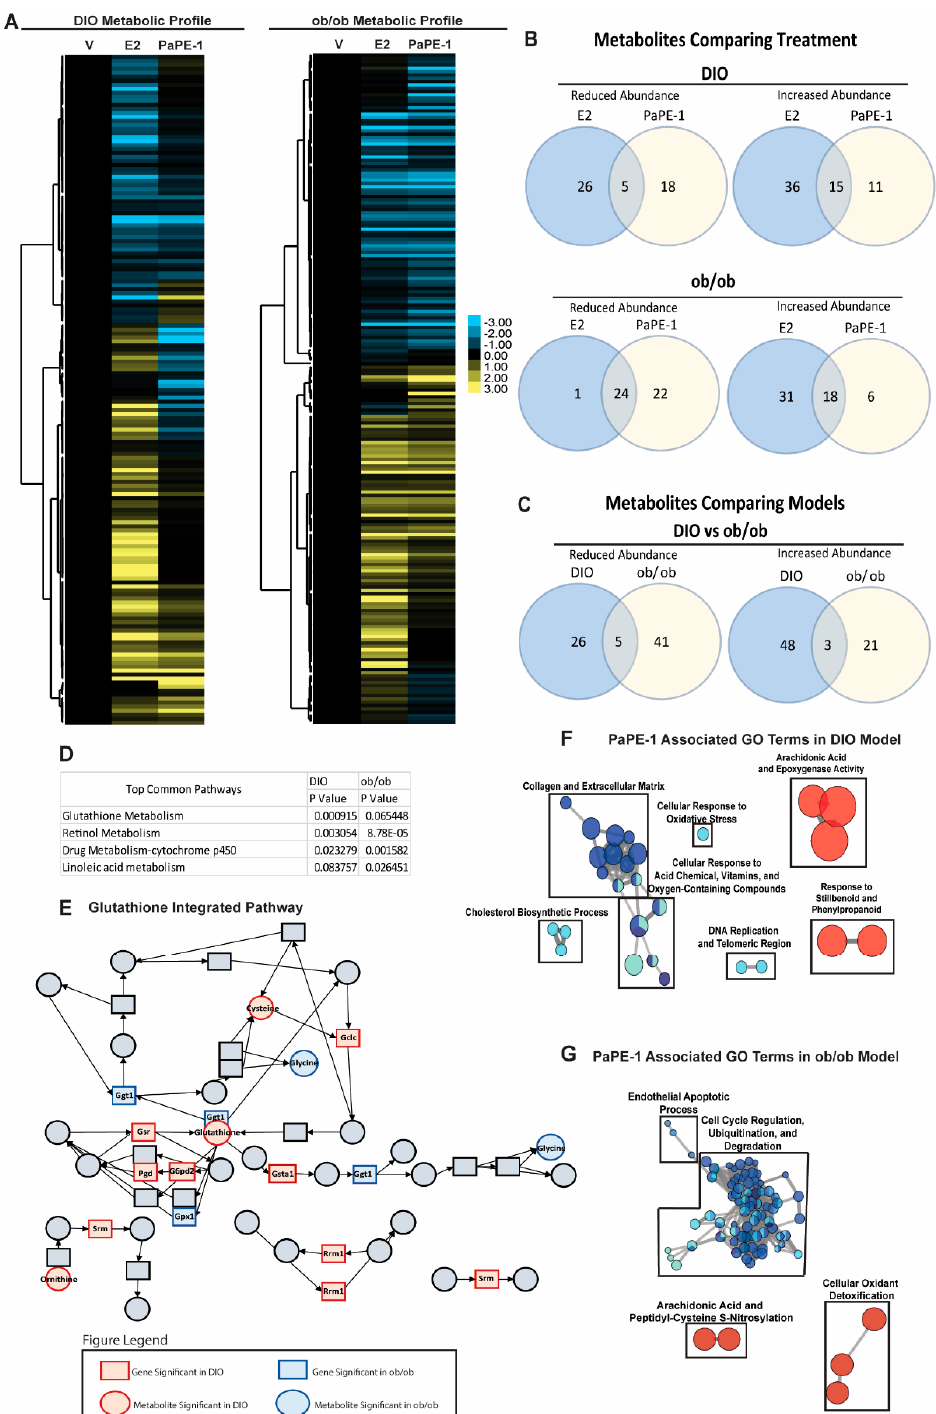
Figure 6. Metabolomics and integrated pathway analysis of PaPE − 1 treatment in DIO and ob/ob mice. ( A ) Blood serum metabolites of PaPE − 1 treatment in DIO and ob/ob mice. ( A ) Metabolites were identified by the GC − MS analysis and incorporated into a heatmap for visualization. Metabolites were clustered using Cluster 3.0 and visualized using Java TreeView. ( B ) PaPE − 1 regulated several metabolites similarly to E2 treatment. ( C ) There were many metabolites distinct to each mouse model though a few were similar. ( D ) Integrated pathway analysis using Metaboanalyst showed common metabolic pathways affected by PaPE − 1 treatment in both DIO and ob/ob models. The top common pathways between the two mouse models show retinol metabolism and drug metabolism − cytochrome p450 were significantly modulated.